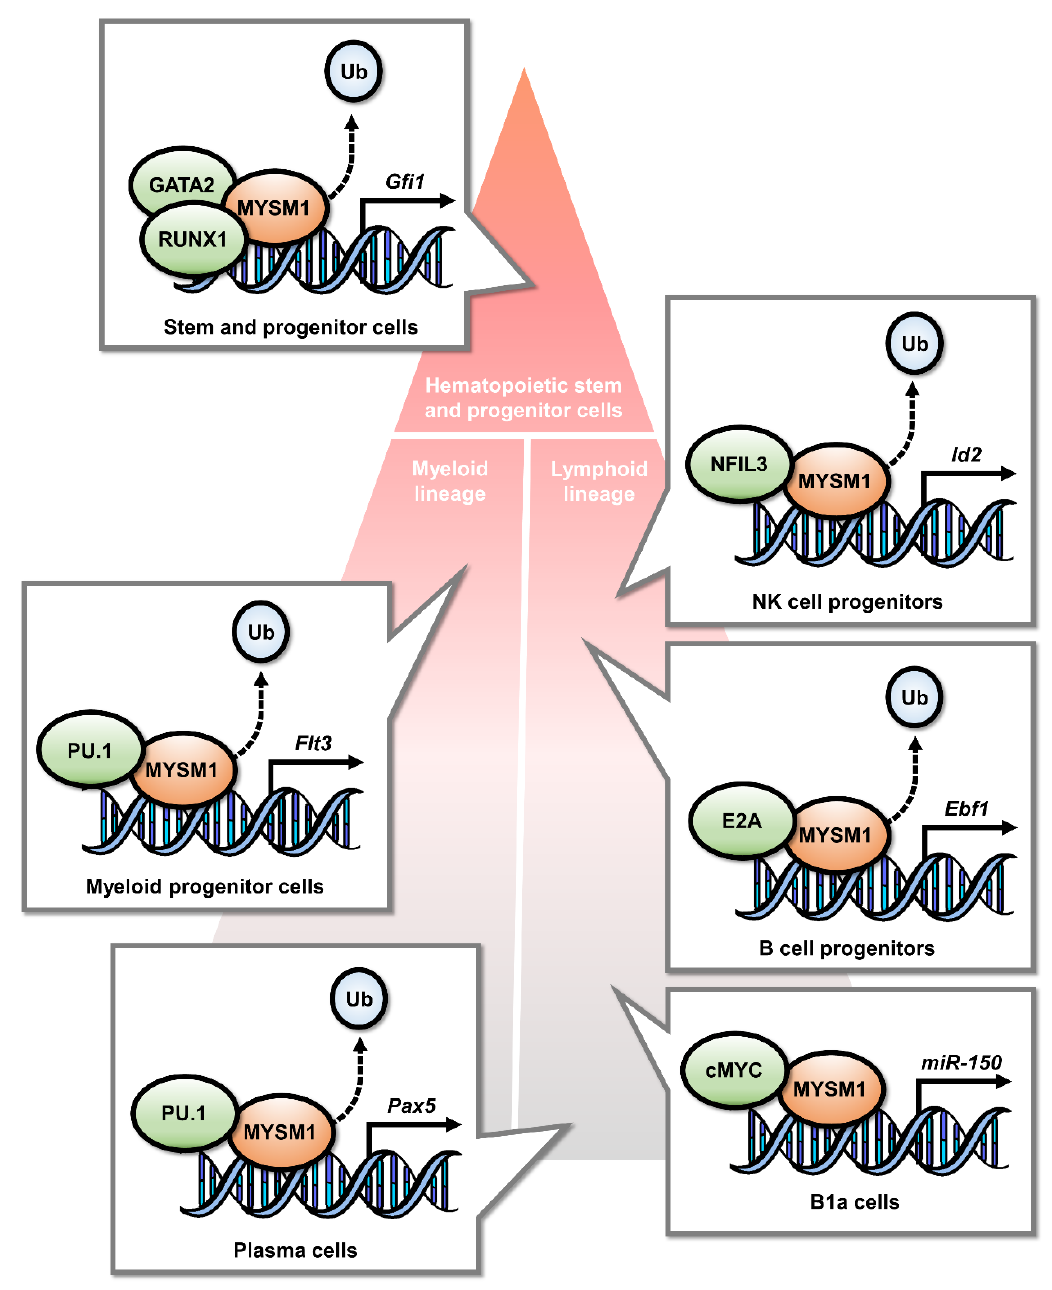
Figure 2. Overview of the reported roles of MYSM1 in the transcriptional regulation of hematopoiesis. MYSM1 was shown to de-repress the expression of Ebf1 in B cell progenitors [20], Pax5 in naïve B cells [30], miR150 in B1a cells [31], Id2 in NK cell progenitors [32], Flt3 in dendritic cell precursors [33], and Gfi1 in hematopoietic stem and progenitor cells [34], through deubiquitination of histone H2AK119ub, and interactions with hematopoietic transcription factors E2A [20], PU.1 [30,33], GATA2 [34], RUNX1 [34], cMYC [31], and NFIL3 [32]. MYSM1 was also shown to interact with many transcriptional regulators through co- immunoprecipitation assays, including essential hematopoietic transcription factors E2A [20], PU.1 [30,33], GATA2 [34], RUNX1 [34], cMYC [31], and NFIL3 [32], as well as the histone acetylase pCAF